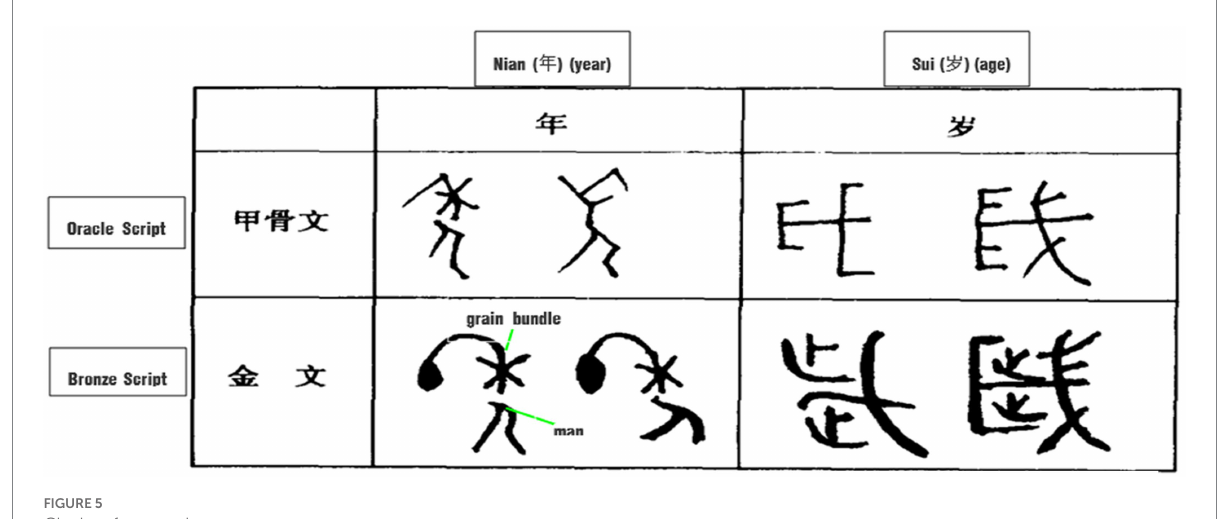
FIGURE 5 Glyphs of year and